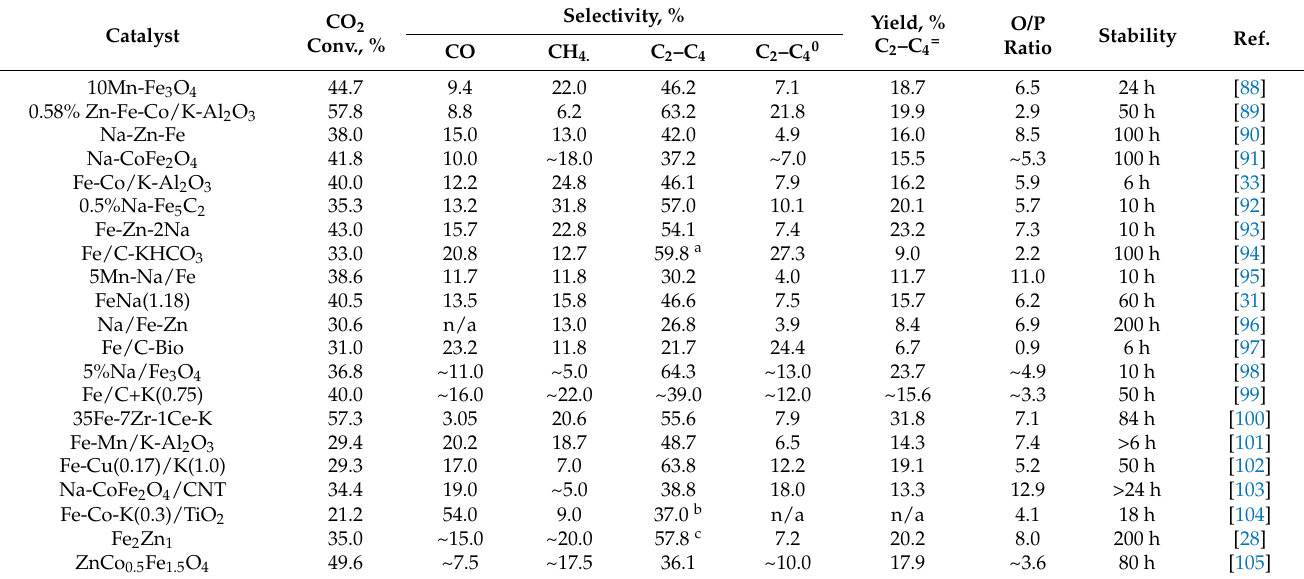
Table 1. Some representative catalysts on promoter effect for CO 2 hydrogenation to light olefins. CO 2 Catalyst Conv.,